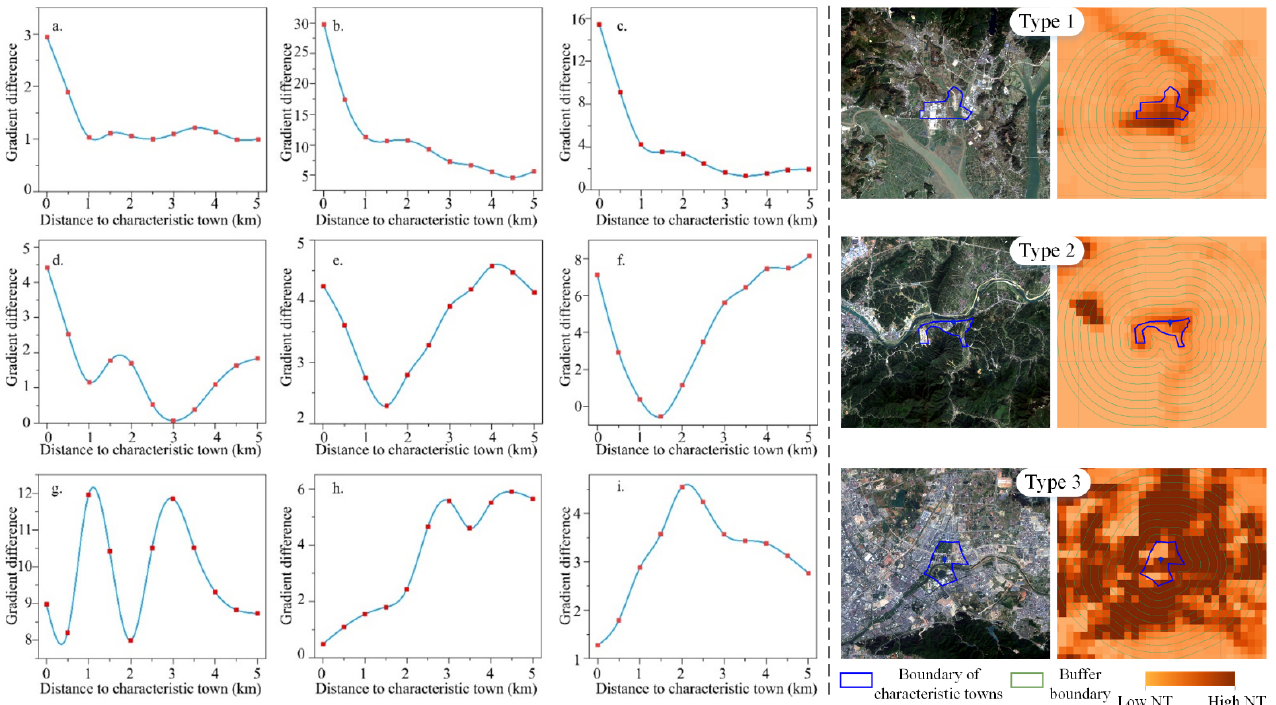
Figure 3. Spatial spillover types and typical cases of characteristic towns (( a – c ) represent type 1, which is consistent with the expected results; ( d – f ) represent type 2, which is partially consistent with the expected results; ( g – i ) represent type 3, which is inconsistent with the expected results. The right figure shows the 3 typical cases of spatial spillover types, including real images and nightlight differential images).